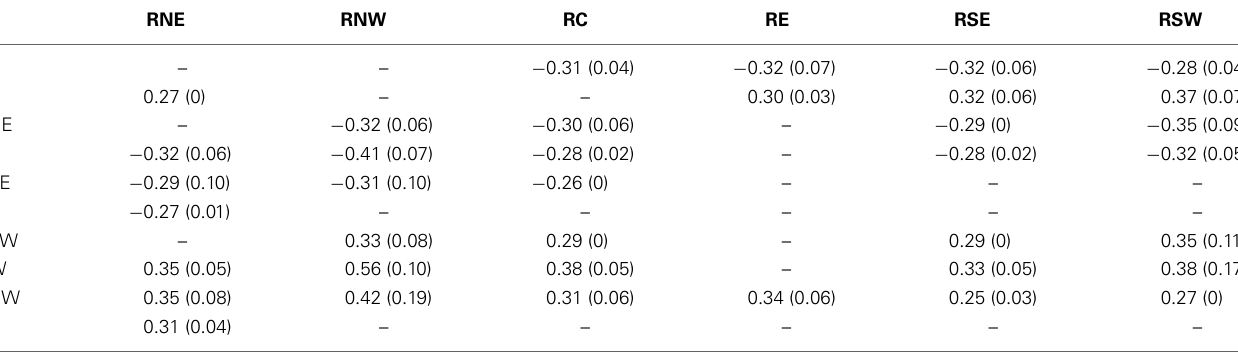
The interquartile range of the correlation values are represented between brackets.